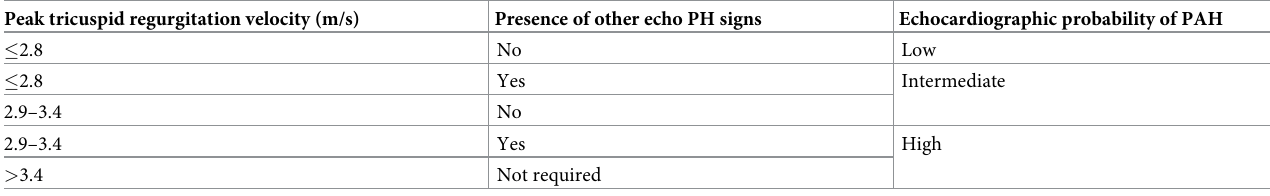
Table 3. Echocardiographic probability of PAH in patients having symptoms indicative of PAH [21]. Peak tricuspid regurgitation velocity